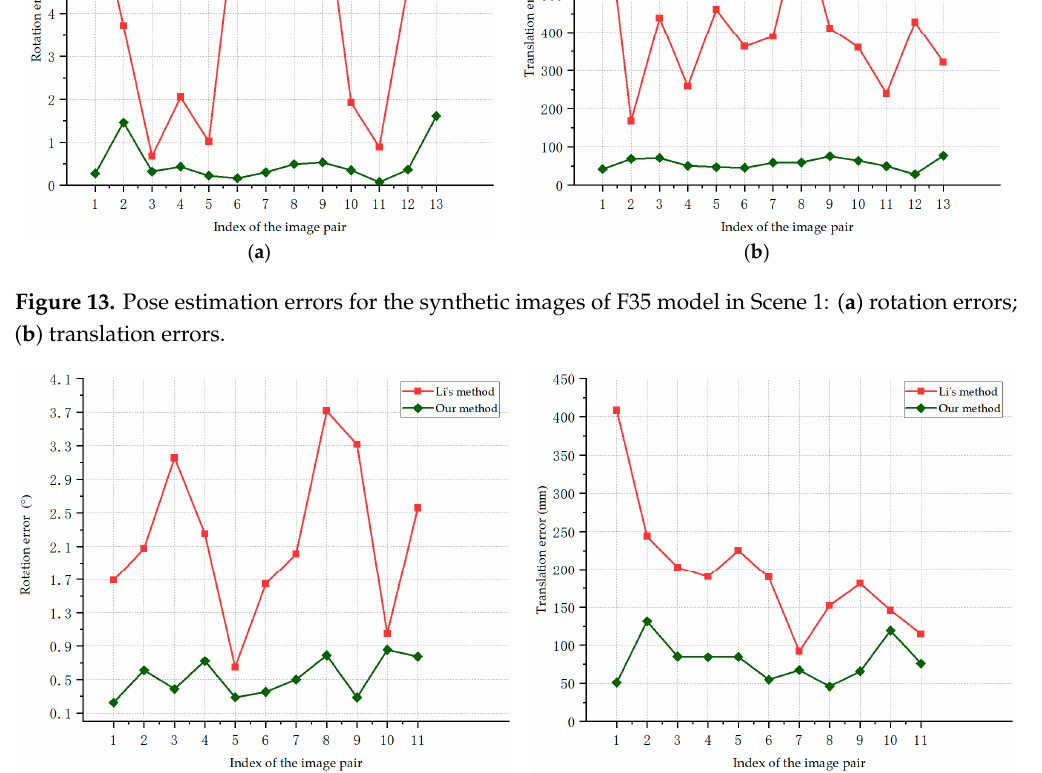
Figure 14. Pose estimation errors on the synthetic images of F35 model in Scene 2: ( a ) rotation errors; ( b ) translation errors.